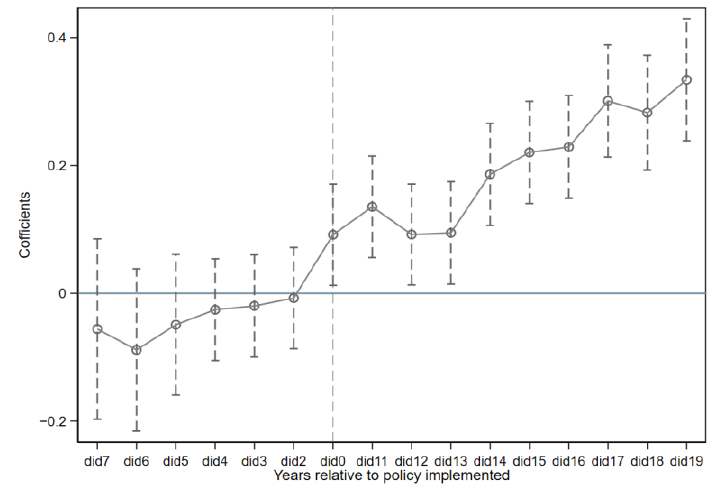
Figure 7. Parallel Trend Test.